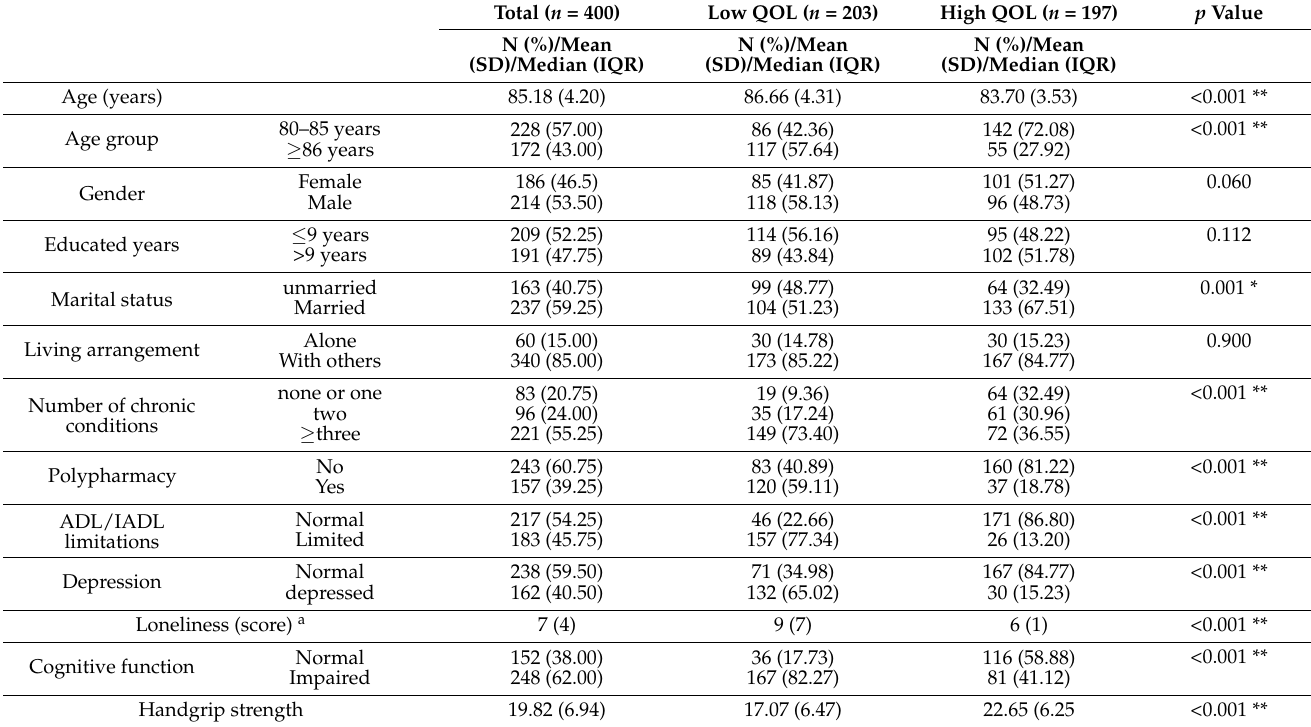
Table 1. Sample characteristics based on a median split of the overall WHOQOL-OLD score ( n =